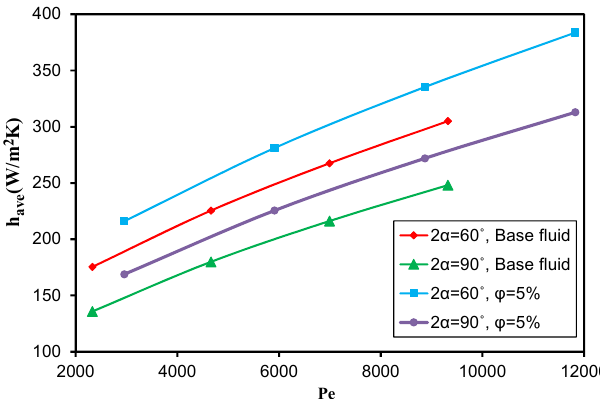
Fig. 6. Average heat transfer coefficient of nanofluids vs. nano- particle concentration for channels with different apex